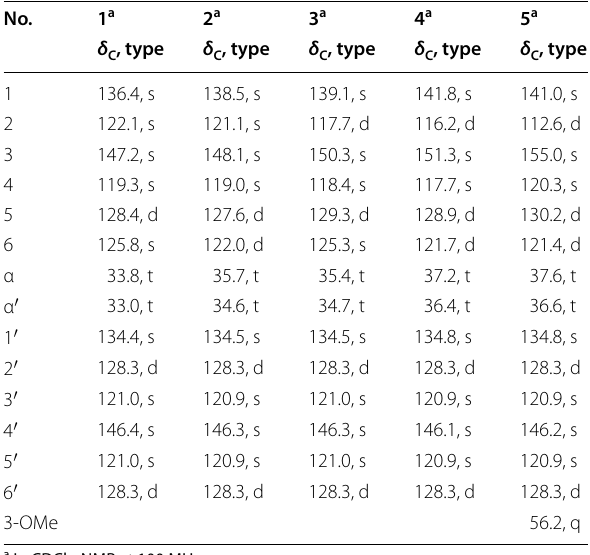
Table 1 13 C NMR data of compounds 1 –